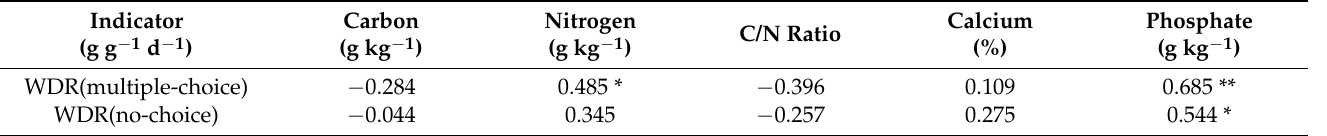
Table 2. Correlation of inorganic chemical characteristics of decaying leaf litter and feeding indicators of Pomacea canaliculata .